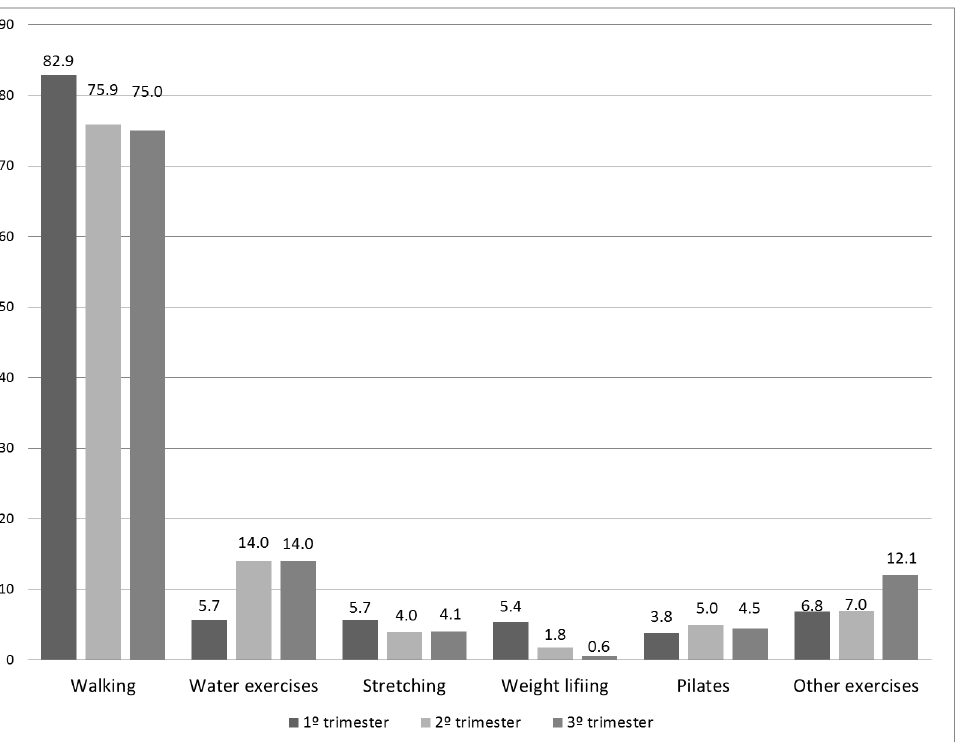
Fig 2. The percentage participating in a given exercise type in each gestational trimester. Other exercises: dance, cycling, swimming, running, prenatal exercise class e pelvic floor exercises.